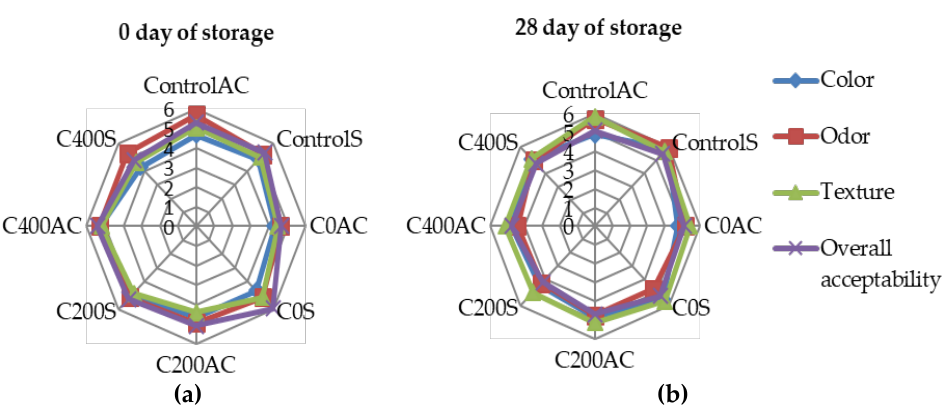
Figure 13. Sensory acceptance of experimental sausages during ( a ) 0 and ( b ) 28 days of storage.